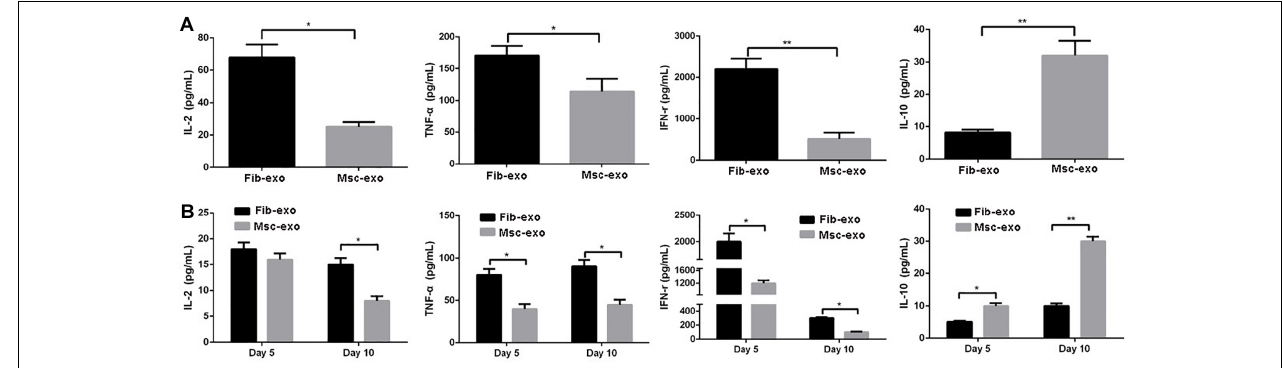
FIGURE 5 | Human bone marrow–derived mesenchymal stem cell (hBMSC)–derived exosomes inhibited inflammatory response related to acute graft-versus-host disease (aGVHD) in vitro and in vivo . (A) Levels of inflammatory cytokines in culture supernatants produced by PHA/rhIL-2-activated human peripheral blood mononuclear cells with or without hBMSC-derived exosomes. (B) Levels of inflammatory cytokines in serum samples in aGVHD mice that did or did not receive hBMSC-derived exosomes on day 5 and day 10 after transplantation. * p < 0.05, ** p < 0.01. IL-2, interleukin-2; INF- γ , interferon- γ ; TNF- α , tumor necrosis factor- α . N = 3–8 in each group. Data were representative of at least two independent experiments.